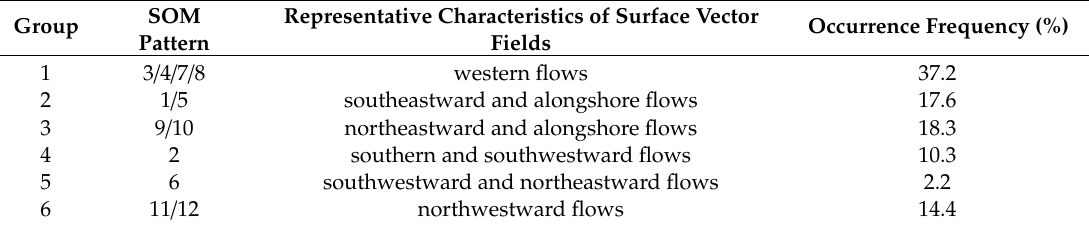
Table 2. Categories of SOM patterns for high frequency radar (HFR)